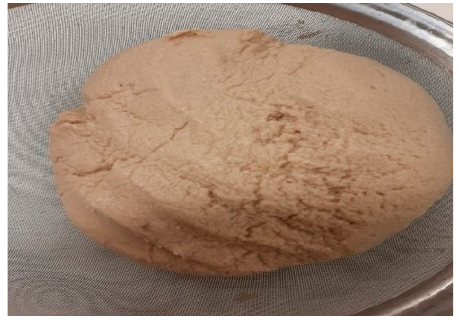
Figure 1. A. oryzae biomass after 48 hours of